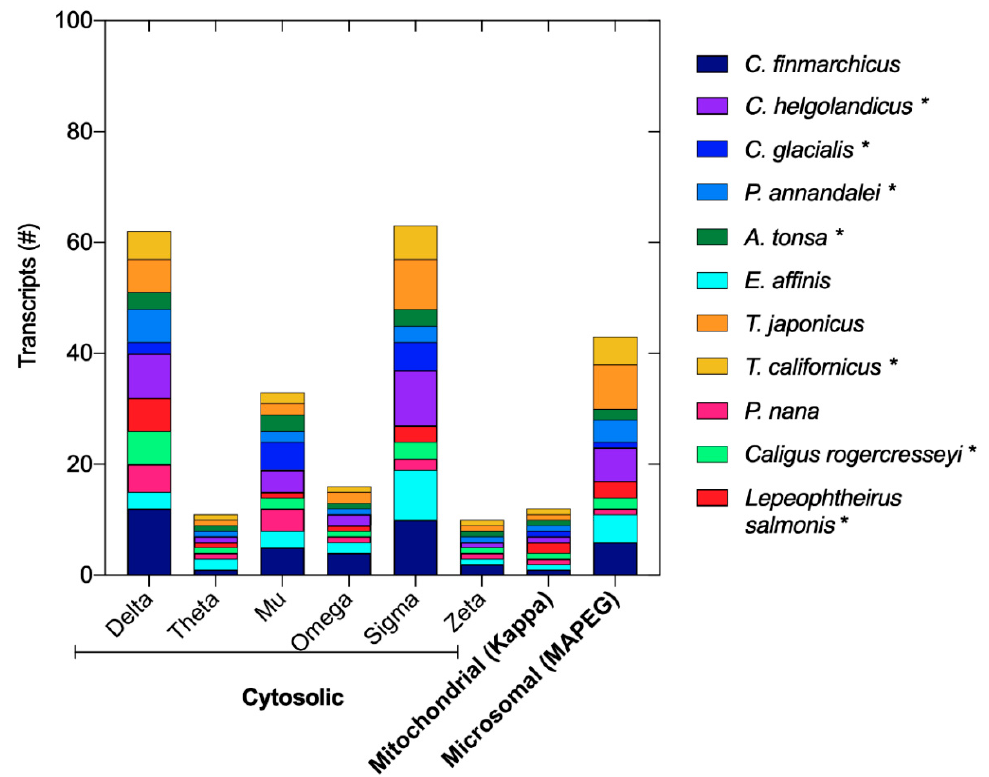
Figure 2. Glutathione S-transferase diversity in marine copepods. Number of transcripts encoding for glutathione S-transferases from the cytosolic, mitochondrial, and microsomal (MAPEG) class. GST diversity identified in this study (*) for the copepods C. helgolandicus , C. glacialis , P. annandalei , A. tonsa , T. californicus , C. rogercresseyi , and L. salmonis compared with the GST diversity previously reported in literature for C. finmarchicus [5], E. affinis [9], T. japonicus , and P. nana [10]). In bold, the three GST classes: cytosolic, mitochondrial (kappa), and microsomal. The cytosolic class includes multiple subclasses as labeled.